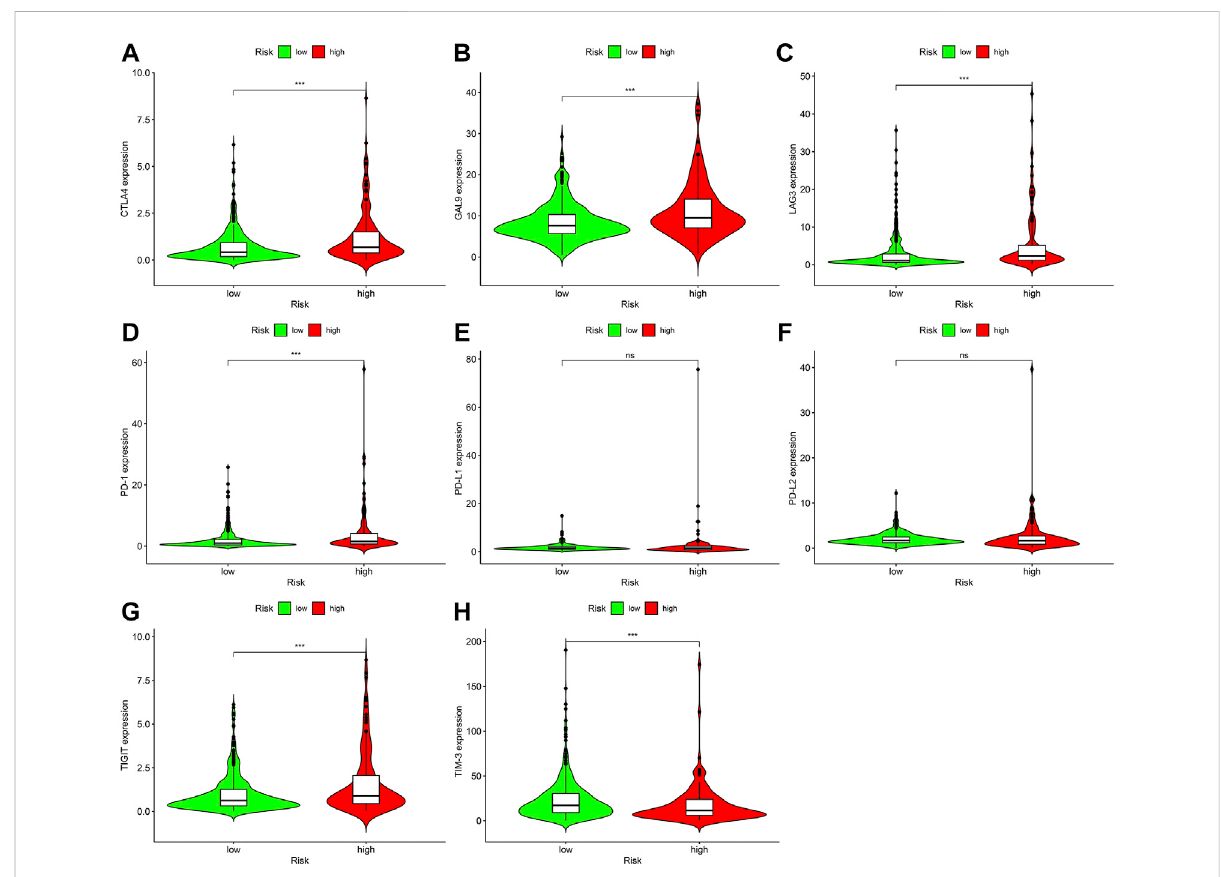
FIGURE 8 Relationship among prognostic signature as well as express standards of immunity checkpoint-associated genes, (A) CTLA4 ( p < 0.001), (B) GAL9 ( p < 0.001), (C) LAG3 ( p < 0.001), (D) PD-1 ( p < 0.001), (E) PD-L1 ( p > 0.05), (F) PD-L2 ( p > 0.05), (G) TIGIT ( p < 0.001), (H) TIM-3 ( p <